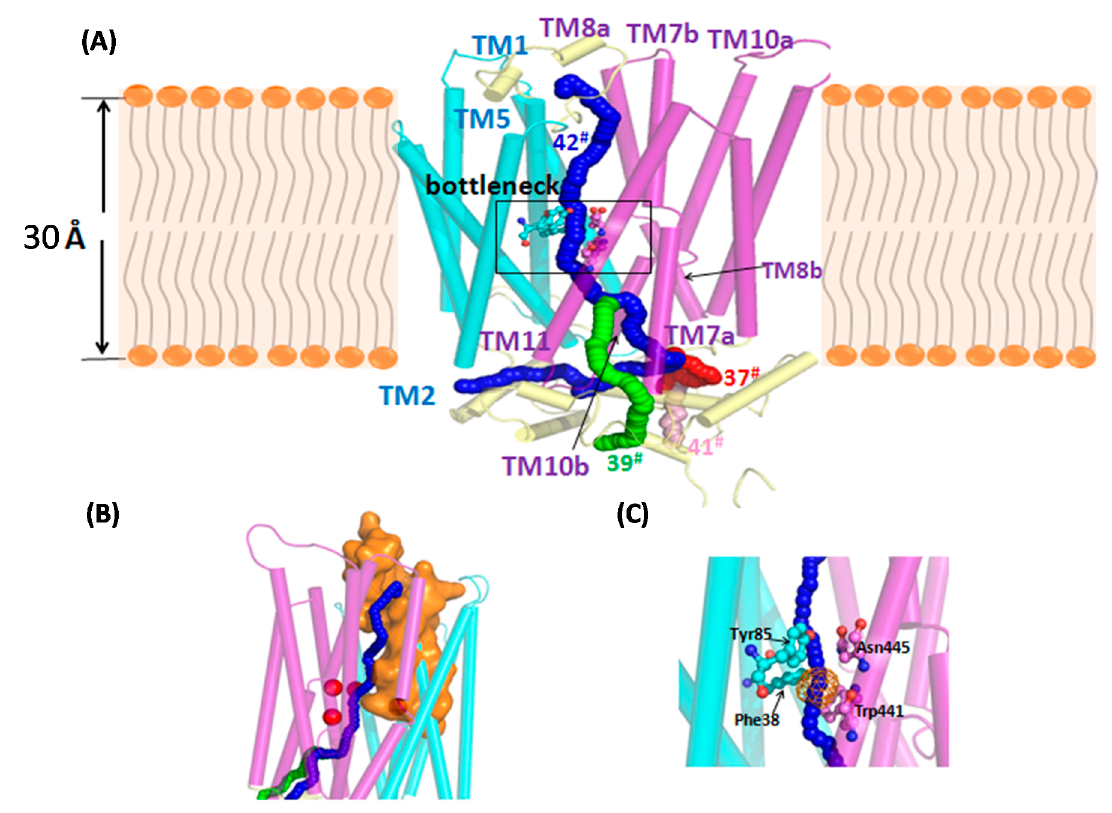
Figure 5. Structural annotation and transport pathway analysis of CCM_06358. Note: ( A ) The modeled structure of CCM_06358 containing 12 transmembrane (TM) helices and 3D-visualization of its four candidate tunnels. Lipid molecules are represented by simple polar heads and hydrophobic tails; ( B ) the tunnels that shared the same entrance are shown in orange; ( C ) the same bottleneck residues are shown in licorice, while the orange wireframe indicates the pocket formed by the four bottleneck residues represented by red spheres i.e., Phe38, Tyr85, Trp441, and